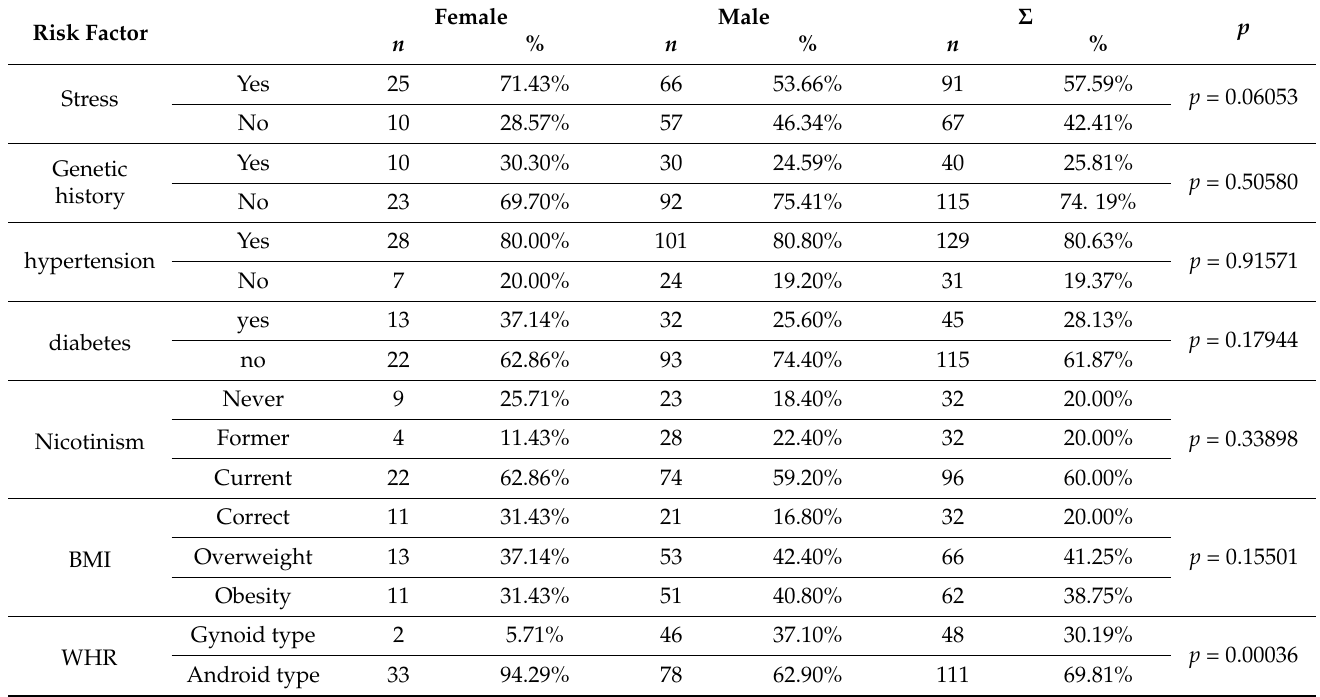
Table 6. Risk factors for